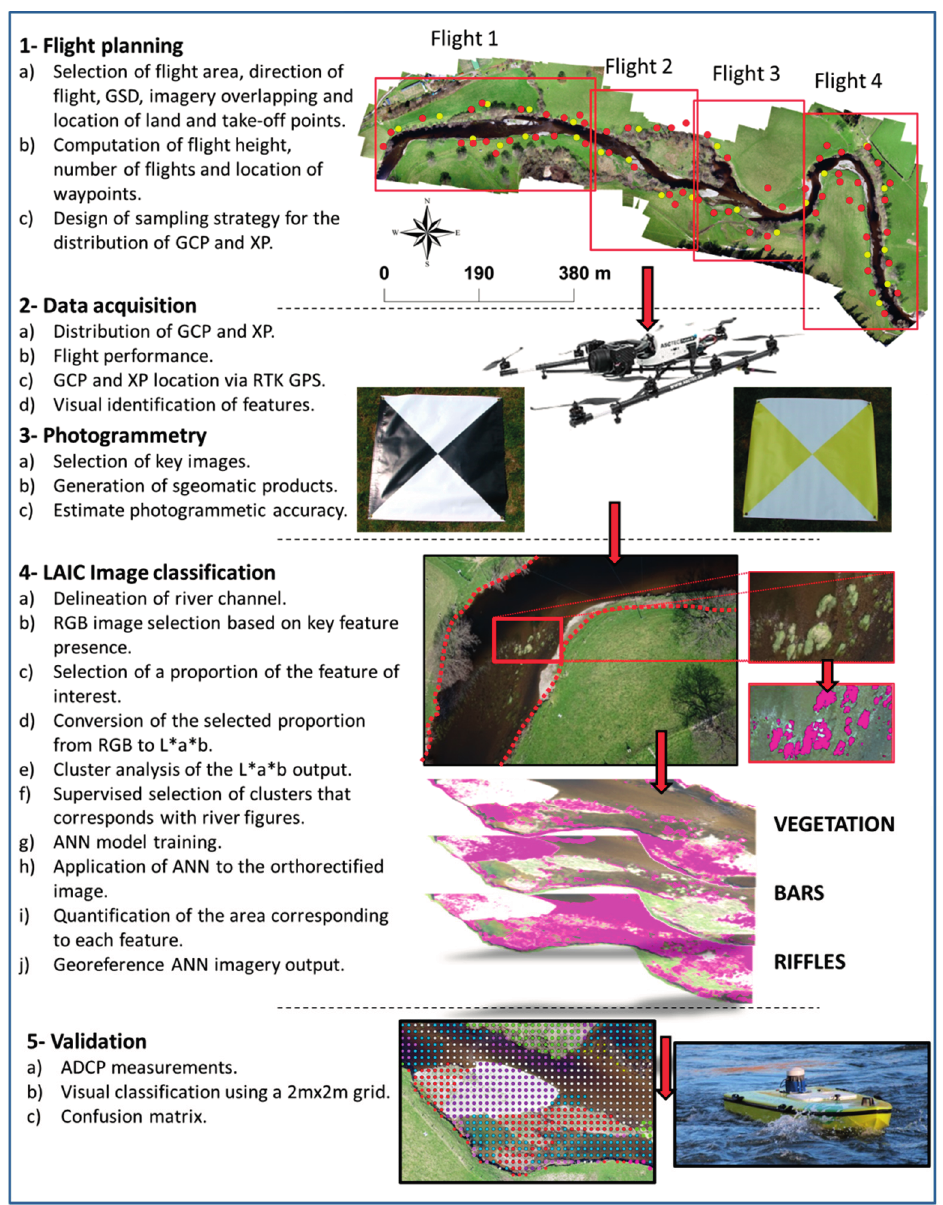
Figure 2. Workflow summarising the steps followed in the photogrammetry using Photoscan Pro and the image classification using the Leaf Area Index Calculation (LAIC) software, based on the workflows presented by [21,37], respectively. GDS, GCP and XP stand for Ground Sampling Distance, Ground Control Point (red points) and Check Point (yellow points),